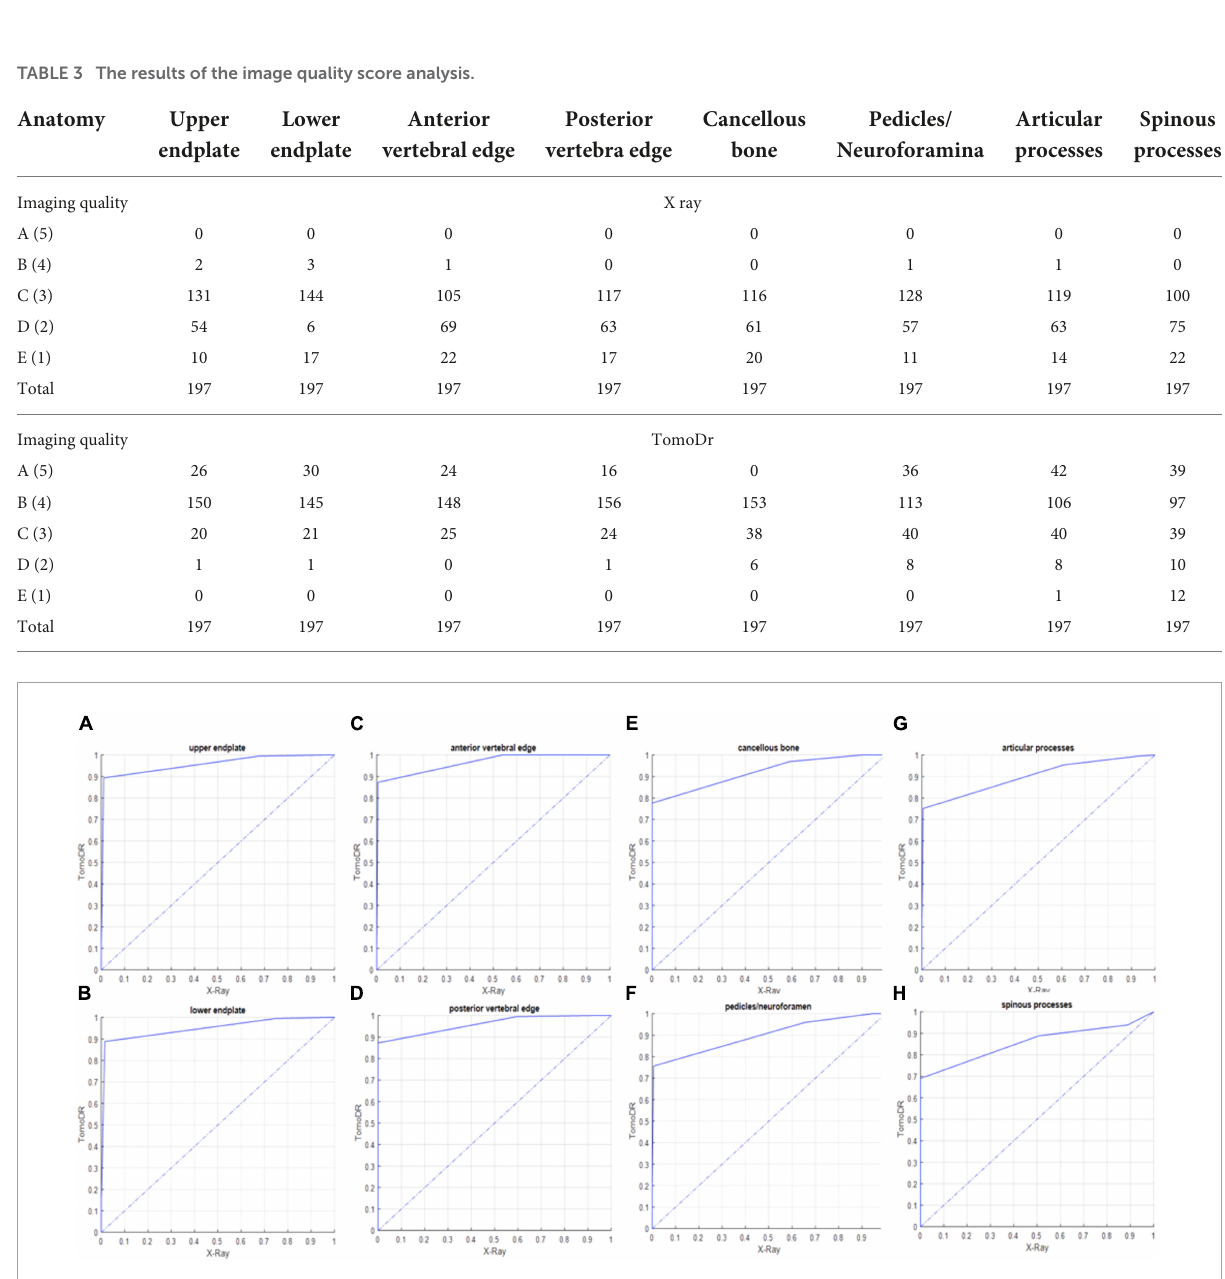
FIGURE3 Receiver operating characteristic (ROC) curve between TomoDR and radiography in the assessment of the (A) upper and (B) lower endplates, (C) anterior and (D) posterior vertebral edges, (E) cancellous bone, (F) pedicles/neuroforamina, (G) articular, and (H) spinous processes of the target levels (fractured levels) using visual grading characteristic (VGC). TomoDR shows better performance in the evaluation of all the